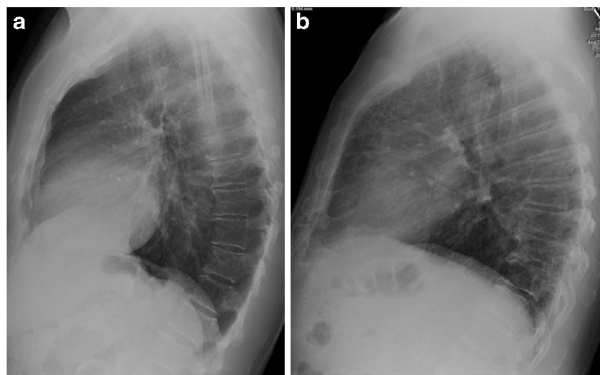
Fig. 5 63-year-old asymptomatic man with a normal radiograph (a) showing fine linear opacities in the retrosternal clear space that taper before reaching the sternum. In contrast, coarse reticular opacities form a mesh and extend to the sternum (b) in a 67-year-old man with an unclassified pulmonary fibrosis (CT